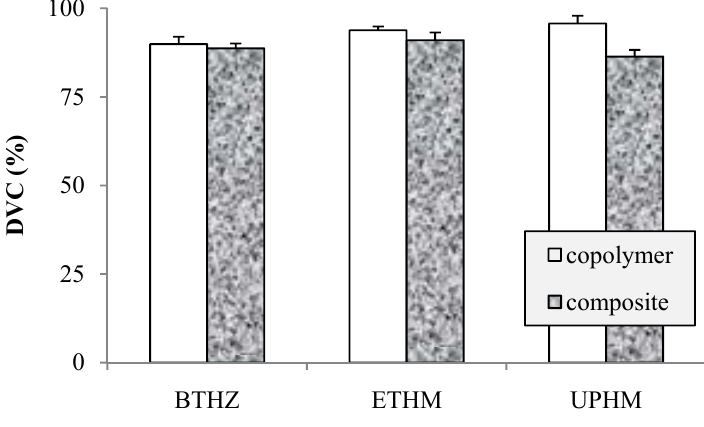
Figure 1. Degree of vinyl conversion [DVC; mean value + standard deviation (SD; indicated by bars)] of unfilled resins (copolymers) and their ACP composites. Number of specimens in each experimental group: 5 ≤ n ≤